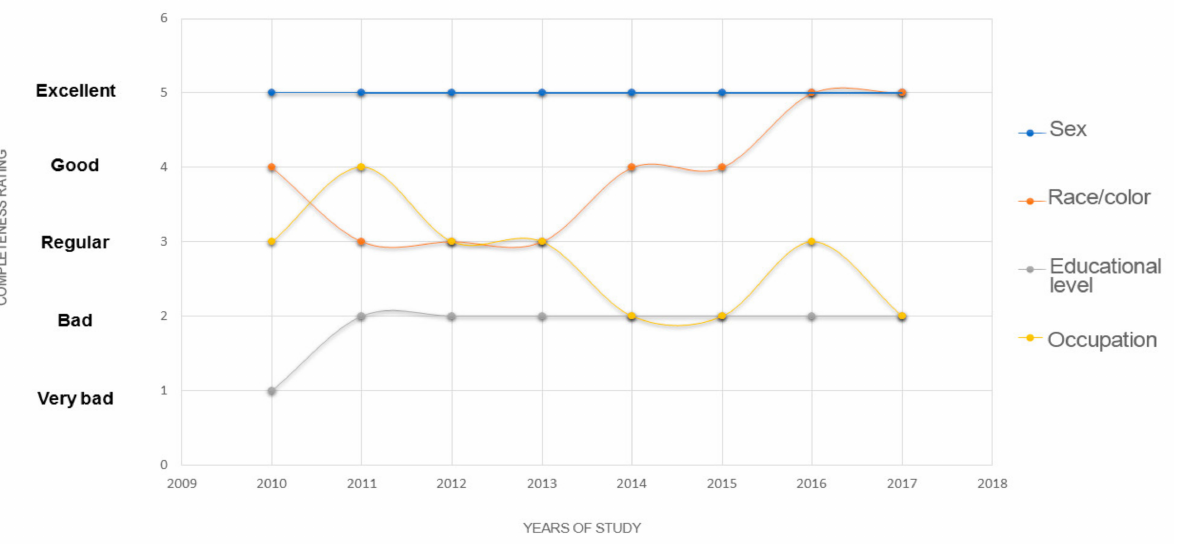
Figure 1. Trends in the completeness of the sociodemographic variables sex, race/color, education, and occupation in the HCR between 2010 and 2017. Vit ó ria, ES,